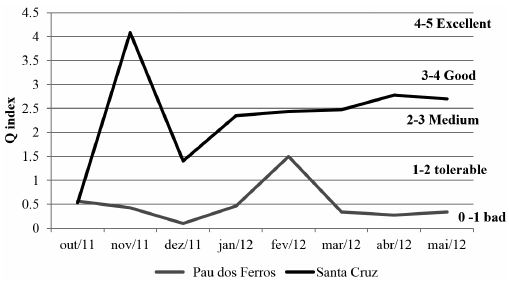
Figure 6. Variation of ecological status according to the application of the index Q in the Pau dos Ferros and Santa Cruz do Apodi reservoirs from October 2011 to May